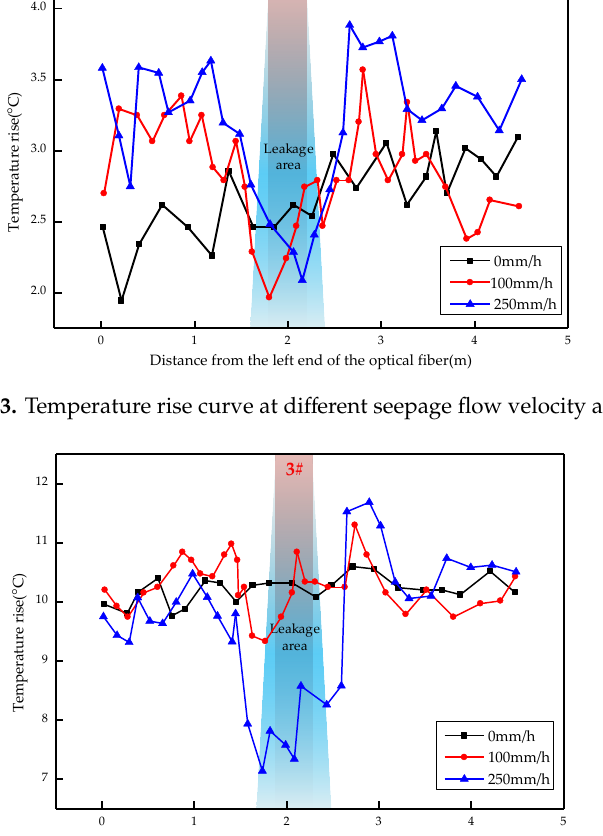
Distance from the left end of the optical fiber(m) Figure 14. Temperature rise curve at different seepage flow velocity at 10 W. Figure 14. Temperature rise curve at di ff erent seepage flow velocity at 10